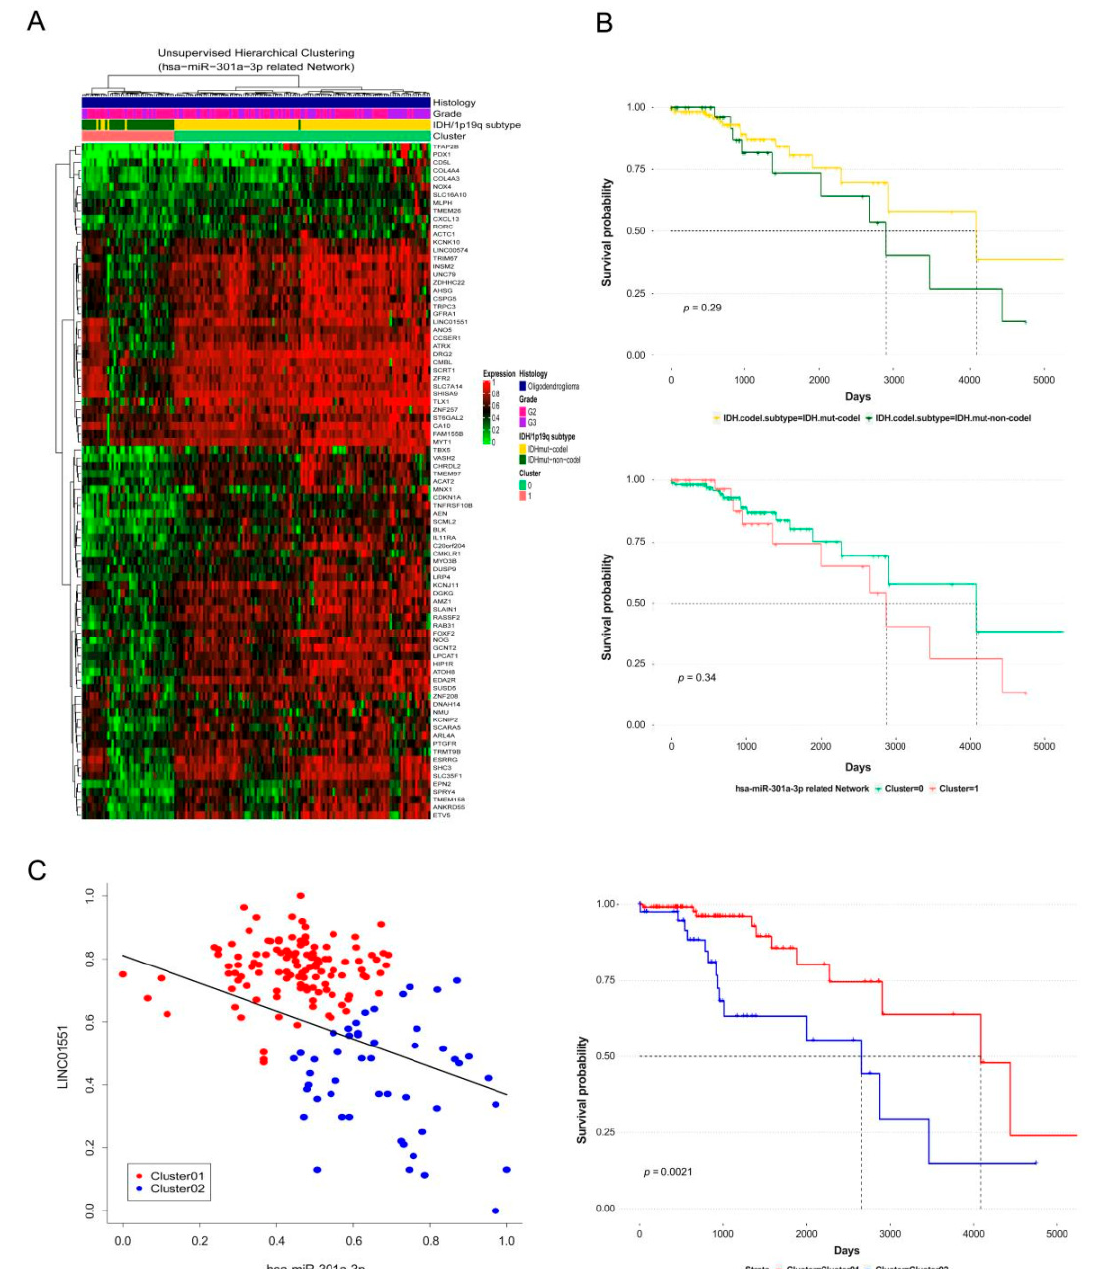
Figure 5. Evaluation of the ceRNA network through by unsupervised clustering and comparing survival to actual OD patients with IDH mutation. Heatmap for unsupervised analysis of DEcodingRNAs and DEncRNAs related to hsa-miR-301a-3p in ceRNA network ( A ). Kaplan–Meier plot for comparing the survival between actual oligodendroglioma patients with IDH mutation from TCGA database and unsupervised group ( B ). The yellow line indicates survival data for OD patients with 1p / 19q codeletion and deep green line for OD patients with 1p / 19q non-codeletion (Top). Olive green and coral pink line indicate groups from unsupervised clustering analysis with miR-301a-3p related ceRNA network (Bottom). Scatter plot for clustering group by K-means in OD patients with IDH mutation ( C ). Scatter plot resenting negative correlations between LINC01551 expected with ceRNA and related to miRNA in ceRNA network (left). Kaplan–Meier survival plot according to the expression levels of ceRNA and miRNA